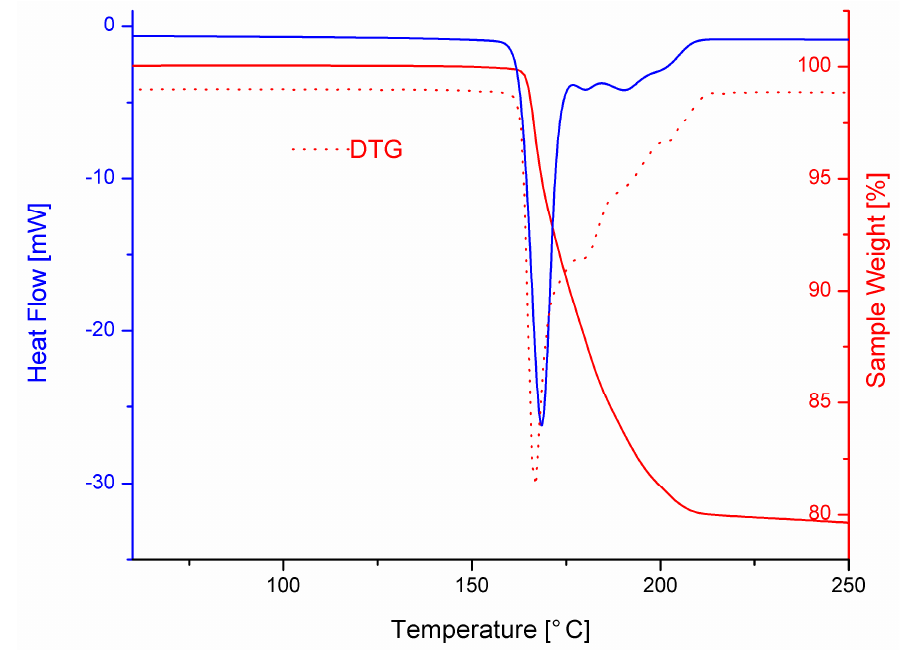
Figure 5. The DSC (blue), thermal (red), and differential thermal (red dotted) curves for the crystalline sample.